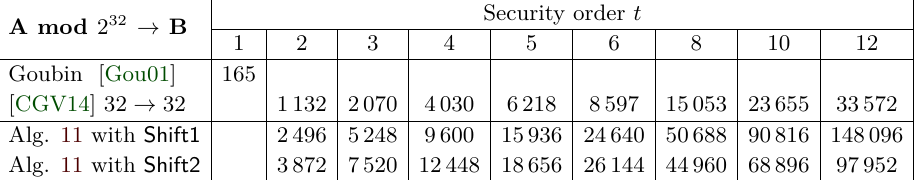
Table 6: Operation count for arithmetic modulo 2 k to k -bit Boolean conversion algorithms, up to security order t = 12, with n = t + 1 shares and k = 32.